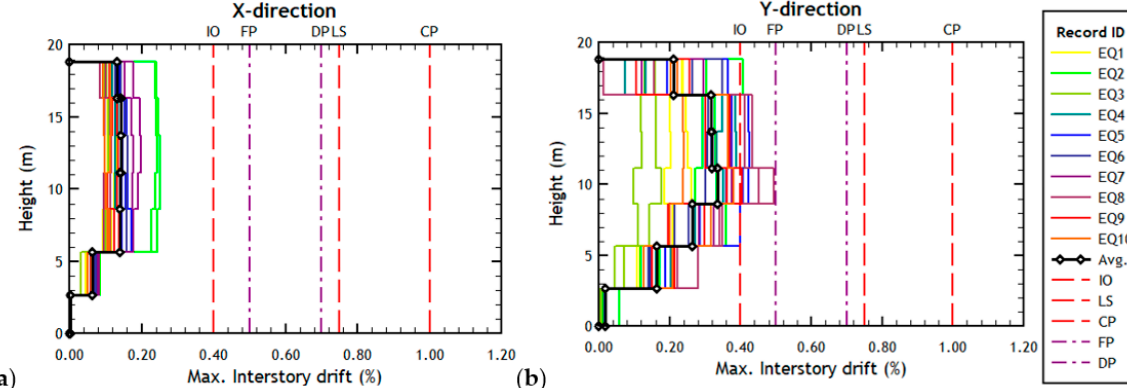
Table 6. Maximum displacement and interstory drift from the analyses in the two directions. Analysis